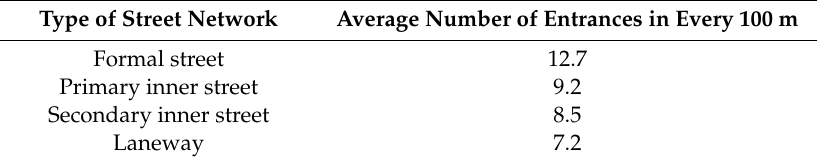
Table 3. Density of entrances by street type.